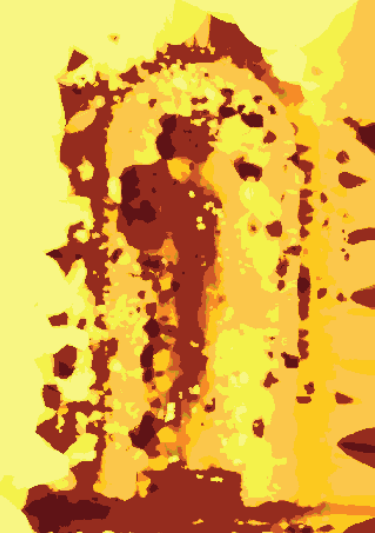
Fig. 5. A digital model taken using the adaptive TIN method